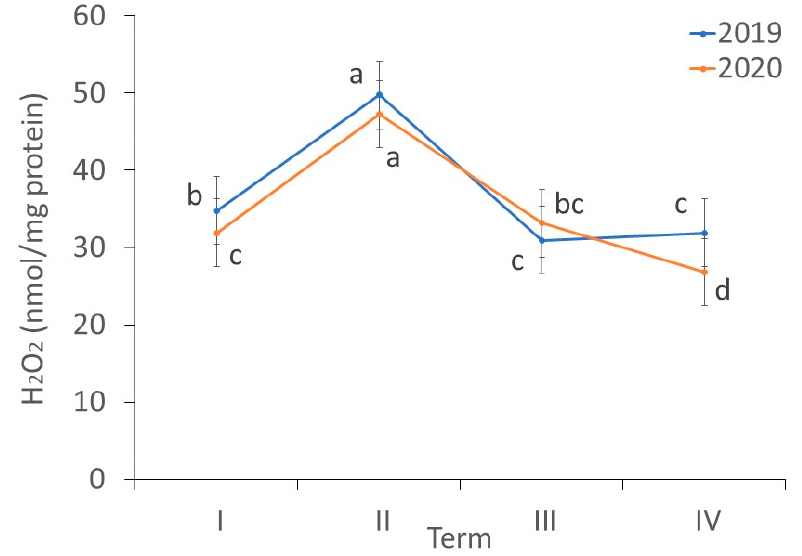
Figure 5. Changes in the hydrogen peroxide (H 2 O 2 ) content (nmol/mg protein) in A. fabae fundatrigeniae during feeding on V. opulus (means ± SD; n = 4). Different letters denote significant differences (one–way ANOVA; Tukey’s test; p < 0.05).